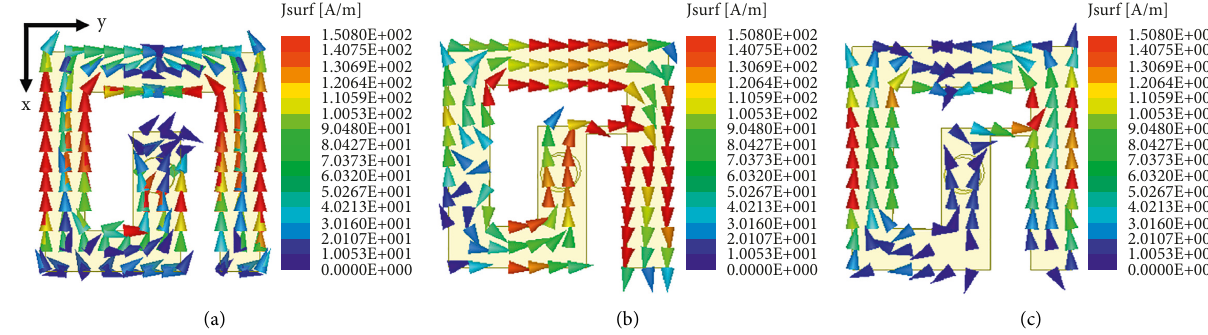
Figure 3: (a) Simulated surface current distribution with U-shape slot loaded. Simulated surface current distribution with the short branch loaded at (b) 10.38GHz and (c) 13.9